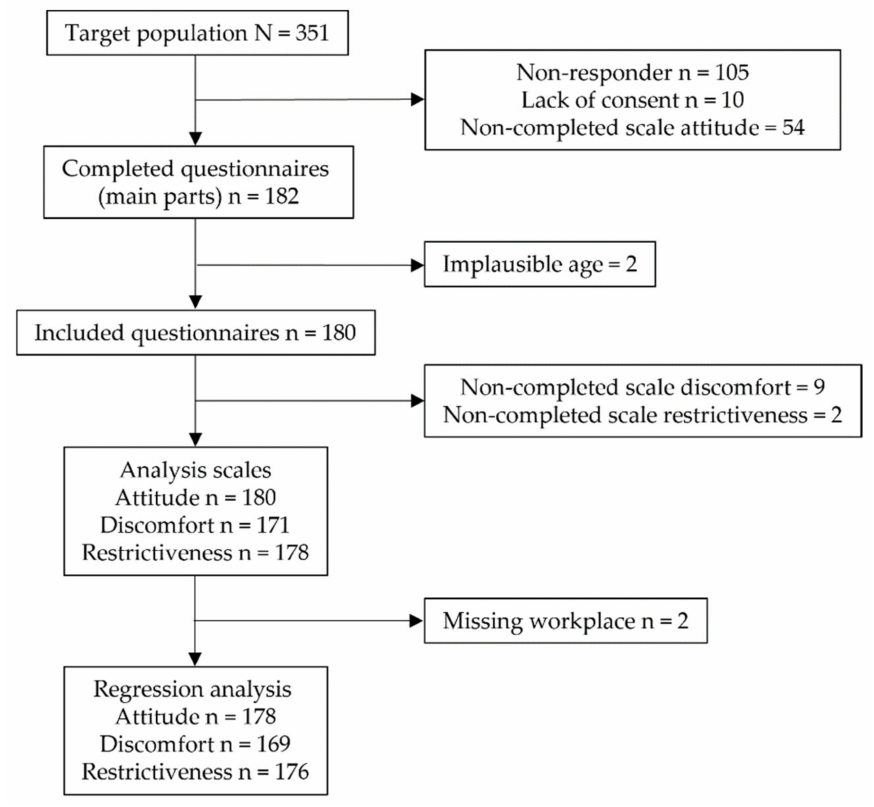
Figure 1. Flowchart detailing the number of participants per analysis step and